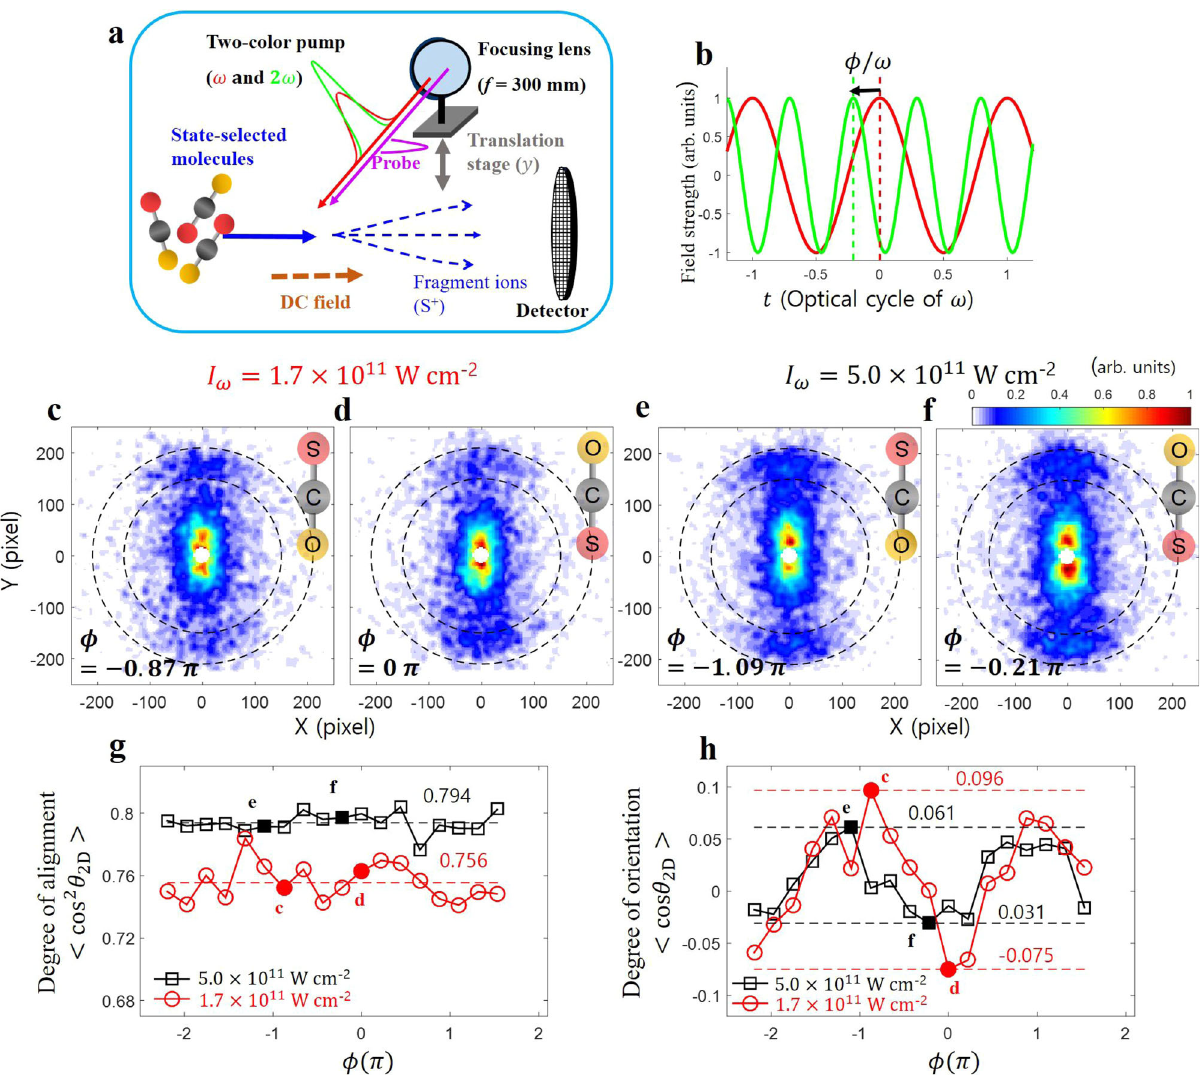
Fig. 3 Experimental observation of the nonadiabatic transition. a Velocity-map imaging for observing molecular orientation. The pump and probe pulses are irradiated to OCS molecules in the rotational ground state. b Schematic representation of the relative phase ϕ between the two wavelengths. c – f Typical images of the S + fragment ions observed in different conditions. g ϕ -independent degrees of alignment cos 2 θ 2D (cid:8) (cid:3) of orientation cos θ 2D for two peak ω intensities of 5.0 × 10 11 W cm − 2 (black) and 1.7 × 10 11 W cm − 2